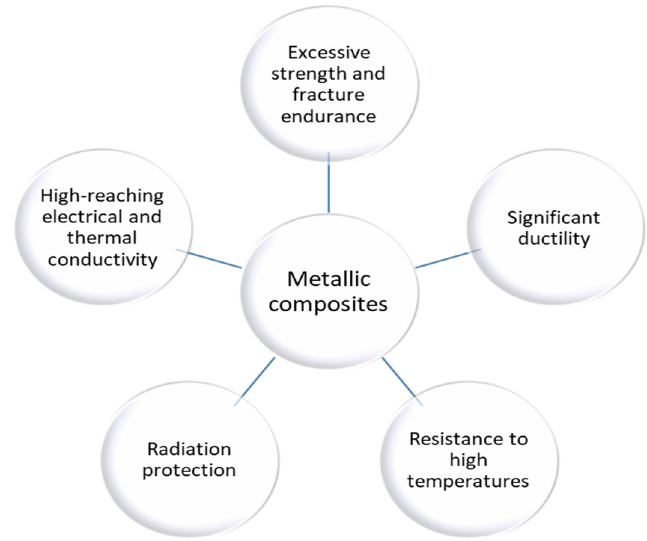
Figure 2. Properties of metallic composites [18] .